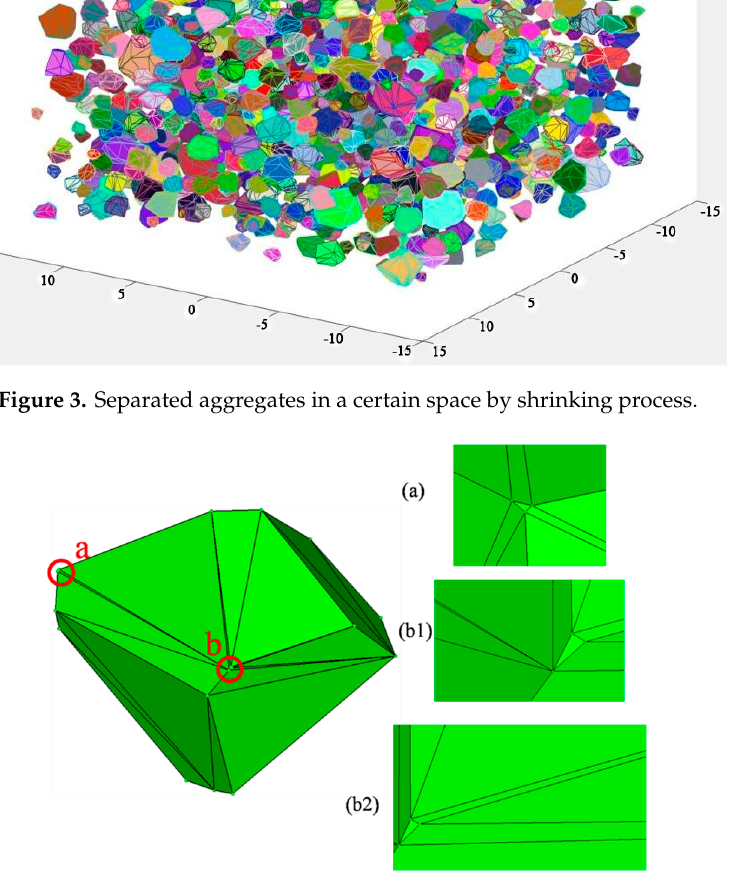
Figure 4. Defects in geometry features after separated process: ( a ) Small area at location “a”, ( b1 ) short sides at location “b”, ( b2 ) sharp triangle with a small angle and long sides at location “b”.